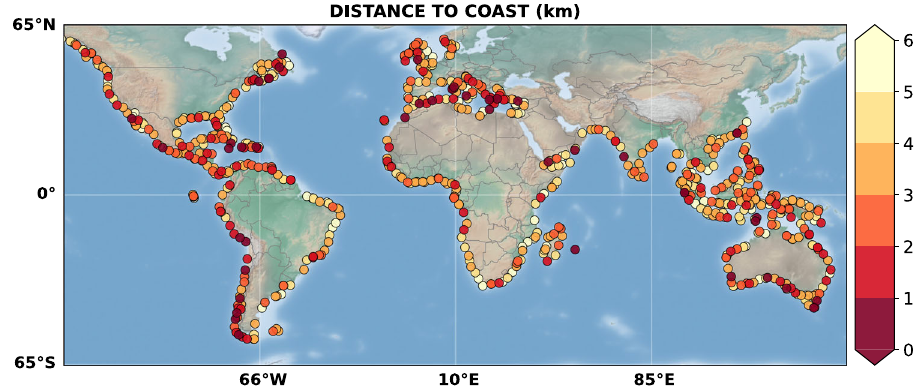
Fig. 2 Distance to coast of the 756 virtual coastal stations. Dots represent the location of the virtual coastal stations and associated colors indicate the closest distance (km) to the coast reached by the fi rst valid point along the